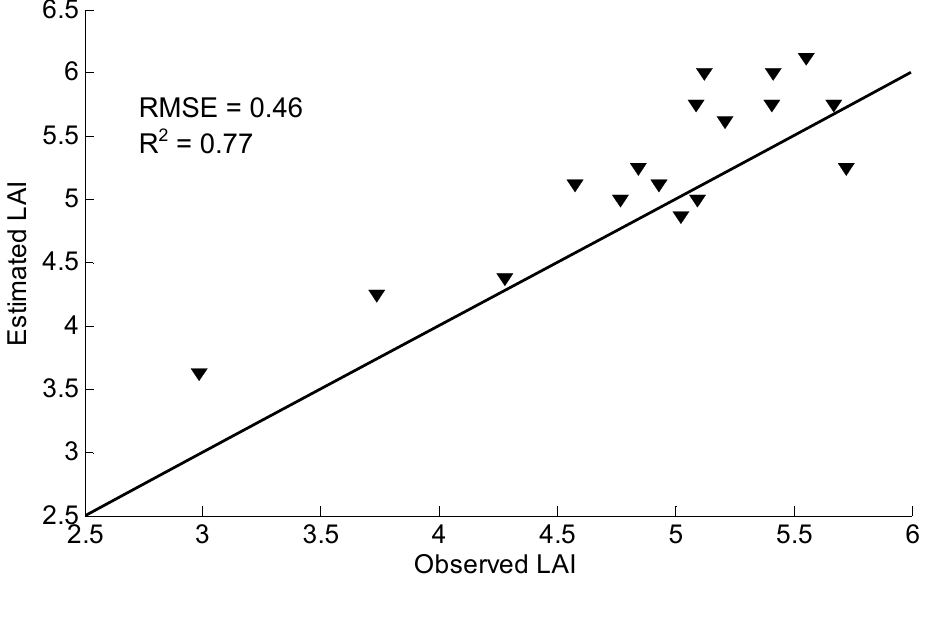
Figure 3. Observed versus best estimated LAI from wavelet coefficients corresponding to 99.99% of total energy (ENERGY SUBSET 1). LAI was estimated as the median value of 30